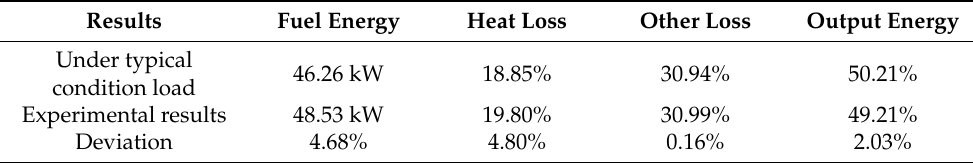
Table 4. Engine energy flow results comparison under operation conditions.